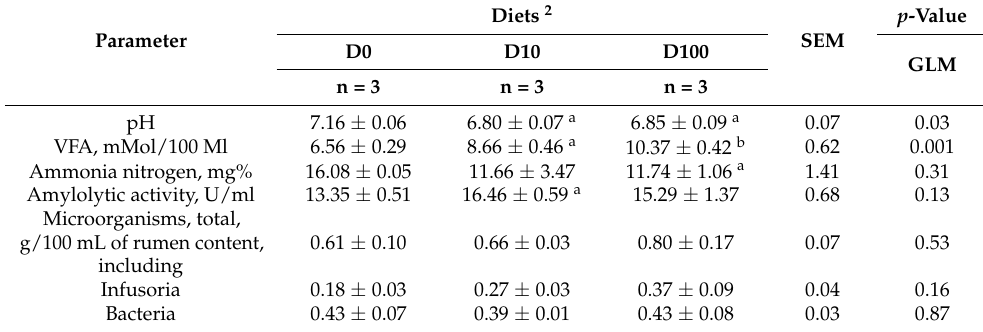
Table 7. Parameters of rumen contents of experimental animals 1 .